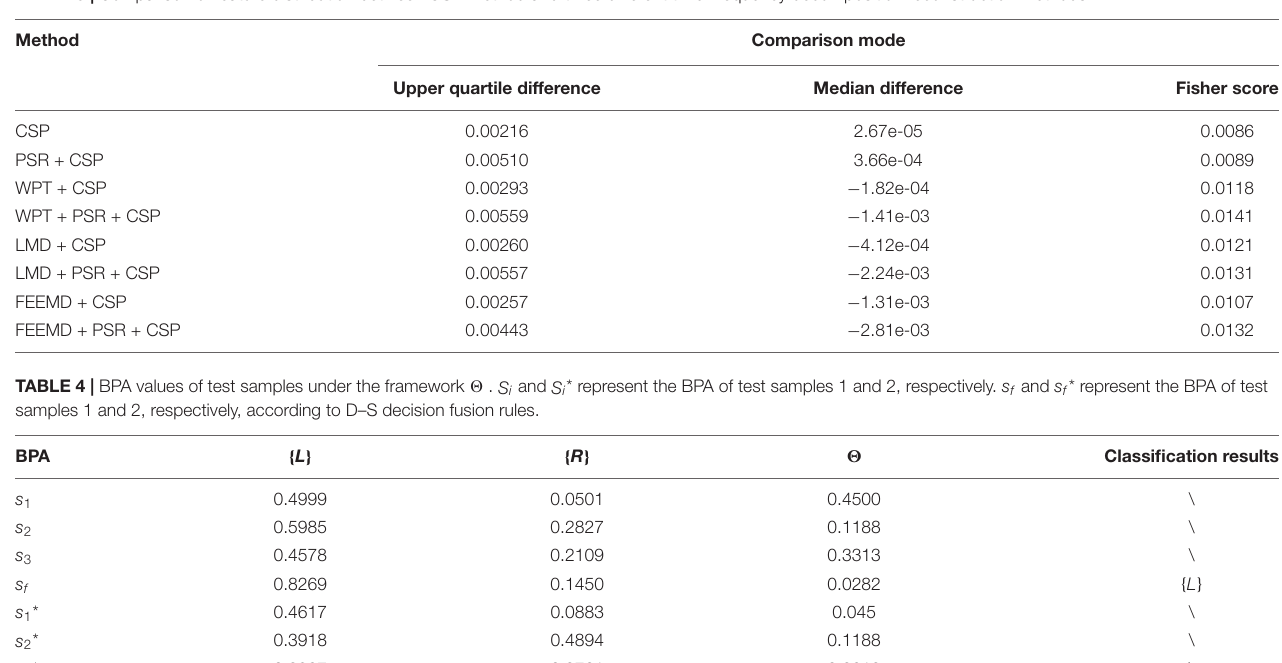
FIGURE 5 | Characteristic box diagram of traditional CSP and of three different time–frequency decomposition and reconstruction methods. M1 represents the characteristic box diagram of CSP; M2 represents the characteristic box diagram of PSR + CSP; M3 represents the characteristic box diagram of WPT + CSP; M4 represents the characteristic box diagram of WPT + PSR + CSP; M5 represents the characteristic box diagram of LMD + CSP; M6 represents the characteristic box diagram of LMD + PSR + CSP; M7 represents the characteristic box diagram of FEEMD + CSP; M8 represents the characteristic of box diagram FEEMD + PSR + CSP. TABLE 3 | Comparison of feature distribution between CSP method and three different time–frequency decomposition reconstruction methods.